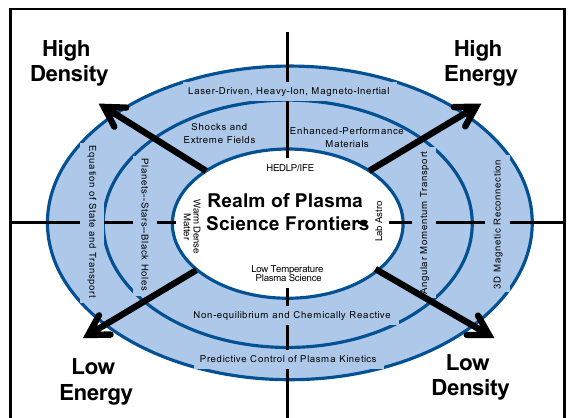
Figure 2. Phenomenological regimes depicted on a circular energy–density range. Angular dispersion of regimes emphasizes their unbiased priority assignment in discovery science.